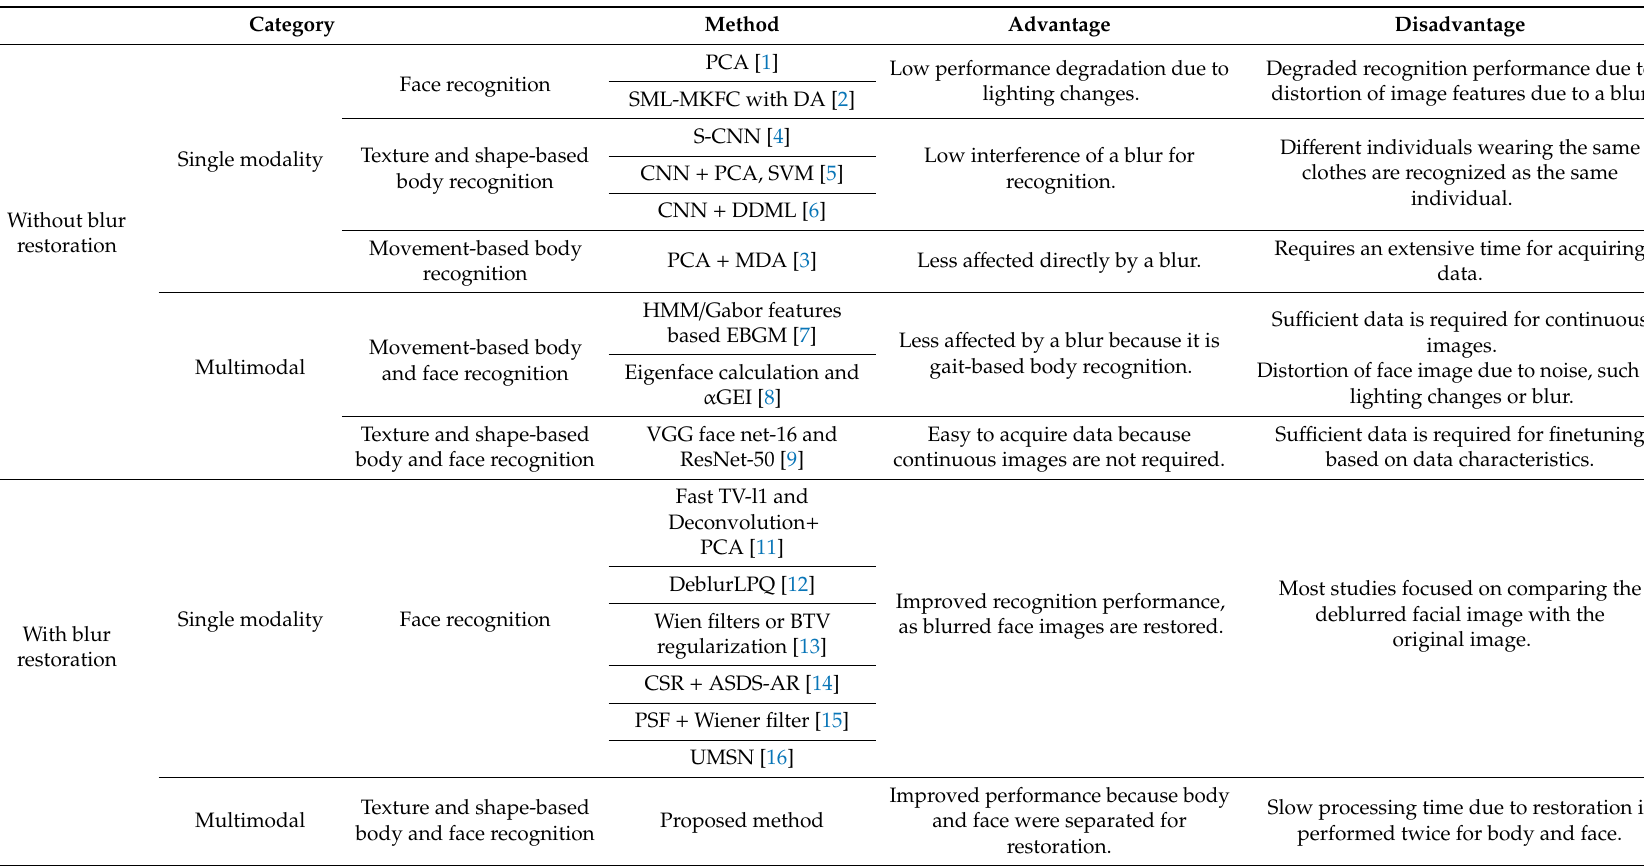
Table 1. Summary of this study and previous studies on person recognition using surveillance camera